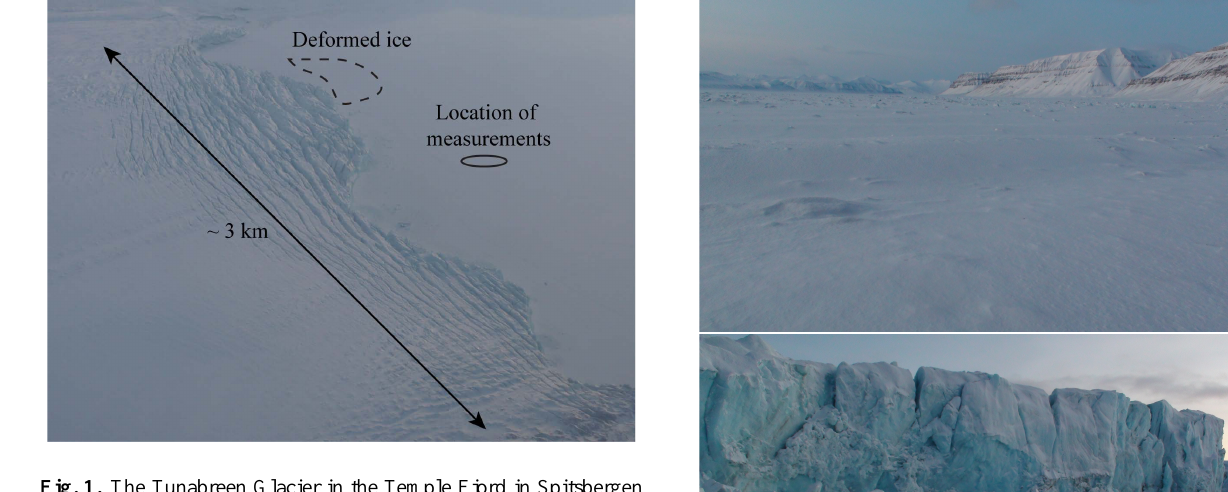
Fig. 1. The Tunabreen Glacier in the Temple Fjord in Spitsbergen (an aerial photo). The horizontal scales on the photo are distorted.